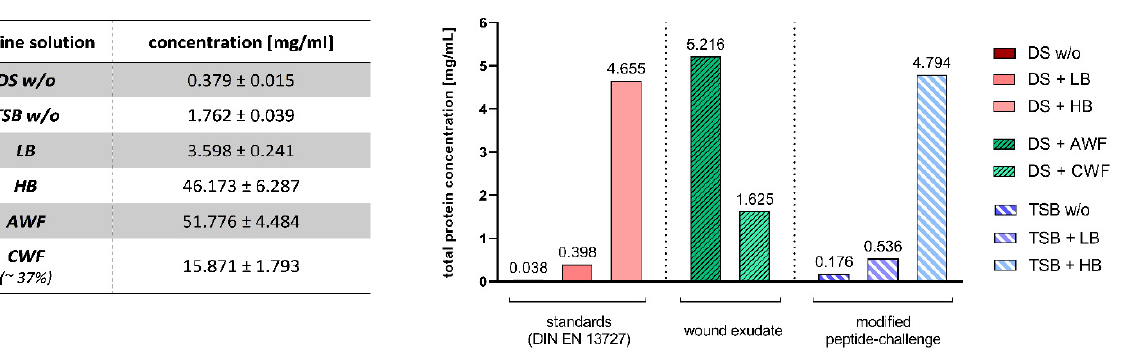
Figure 2. Protein/peptide concentrations in baseline solutions and challenge conditions. Concentra- tions of the various used baseline solutions (mean ± SD in mg/mL) are summarized in the table (left). Final concentrations (in mg/mL) of the different challenge conditions tested in the experimental qualitative suspension method (QSM) experiments are depicted on the right. Concentrations are sums of the combined baseline solution (dilution solution (DS) or tryptone soy broth (TSB)) and added challenge substance (none—w/o, LB, HB, AWF or CWF). Final concentrations in the experiments are 10-fold diluted due to the experimental setup. Due to the necessary sampling methodology, CWF concentration was diluted to about 37% of physiological concentration in the chronic wound bed. (DS w/o: Dilution solution without additional challenge; TSB w/o: Tryptone soy broth without additional challenge; LB: Low burden; HB: High burden; AWF: Acute wound exudate; CWF: Chronic wound exudate).